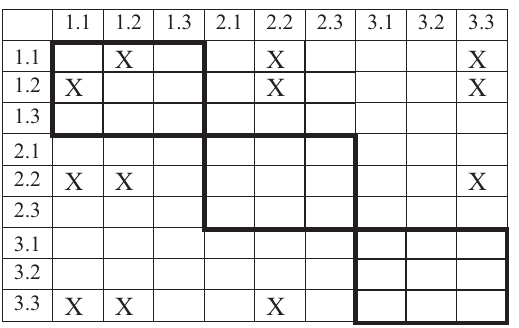
FIG. 3. Example matrix with markings for a sort that grouped problems 1.1, 1.2, 2.2, and 3.3.